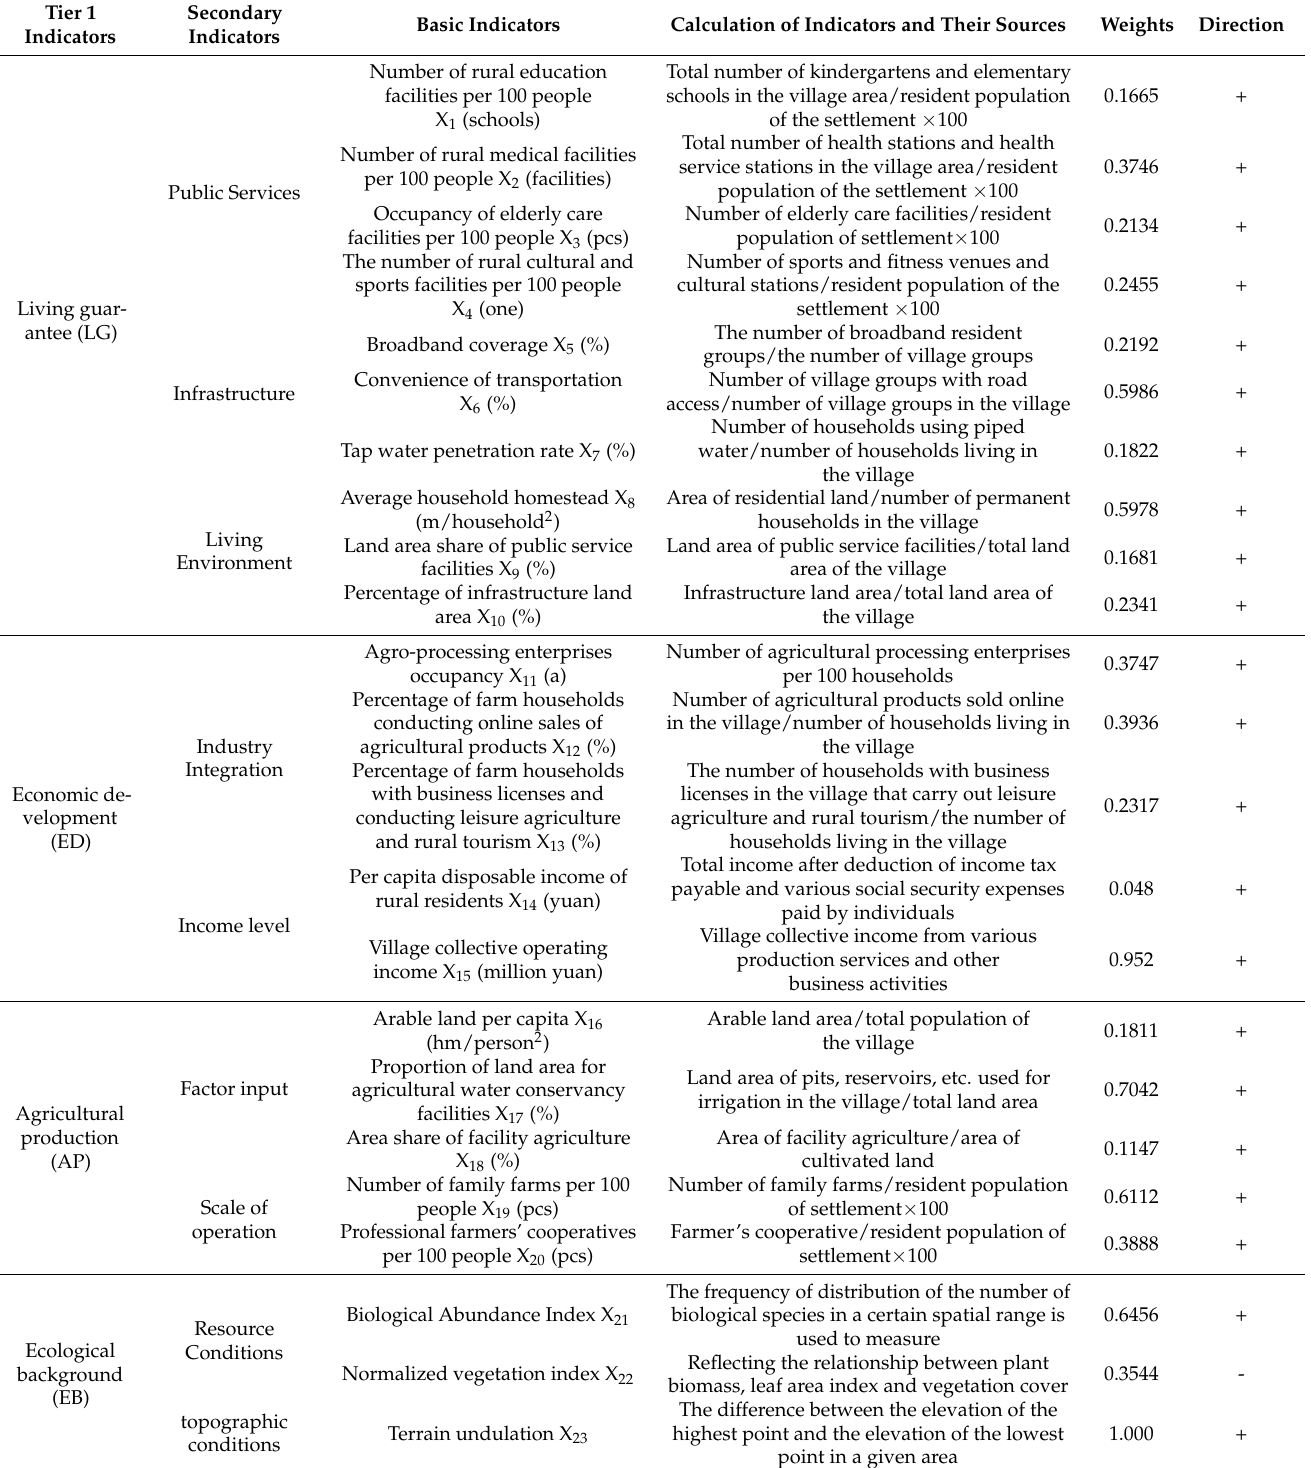
Table 1. Rural multifunctionality evaluation index system of Yongchang